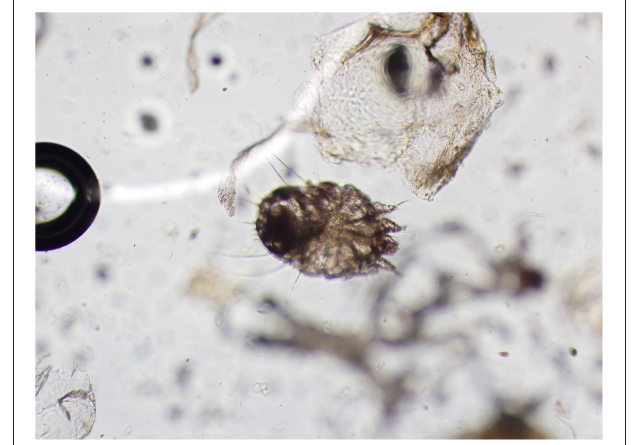
FIGURE 2 | Mite identified from skin scraping (magnification: 20X). Note the long unjointed pedicles, cuticular spines, setae, and terminal anus consistent with Sarcoptes